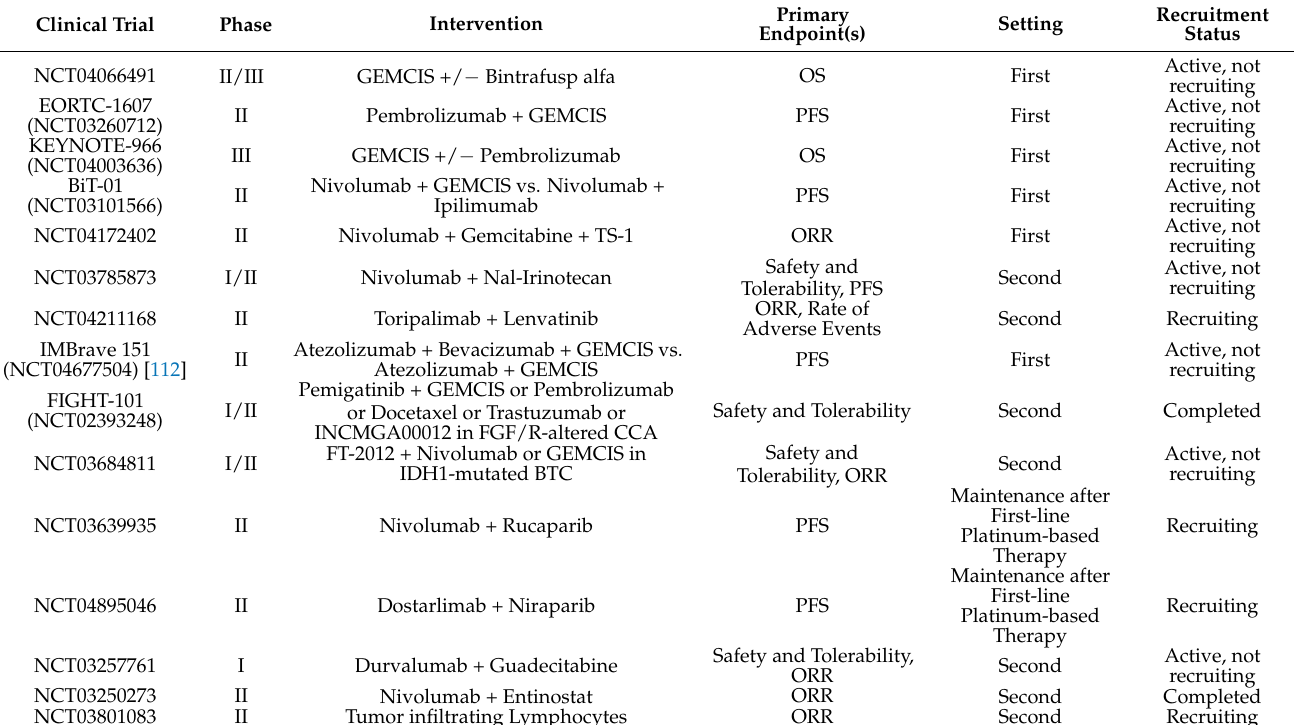
Table 3. Select ongoing clinical trials on immunotherapy in advanced